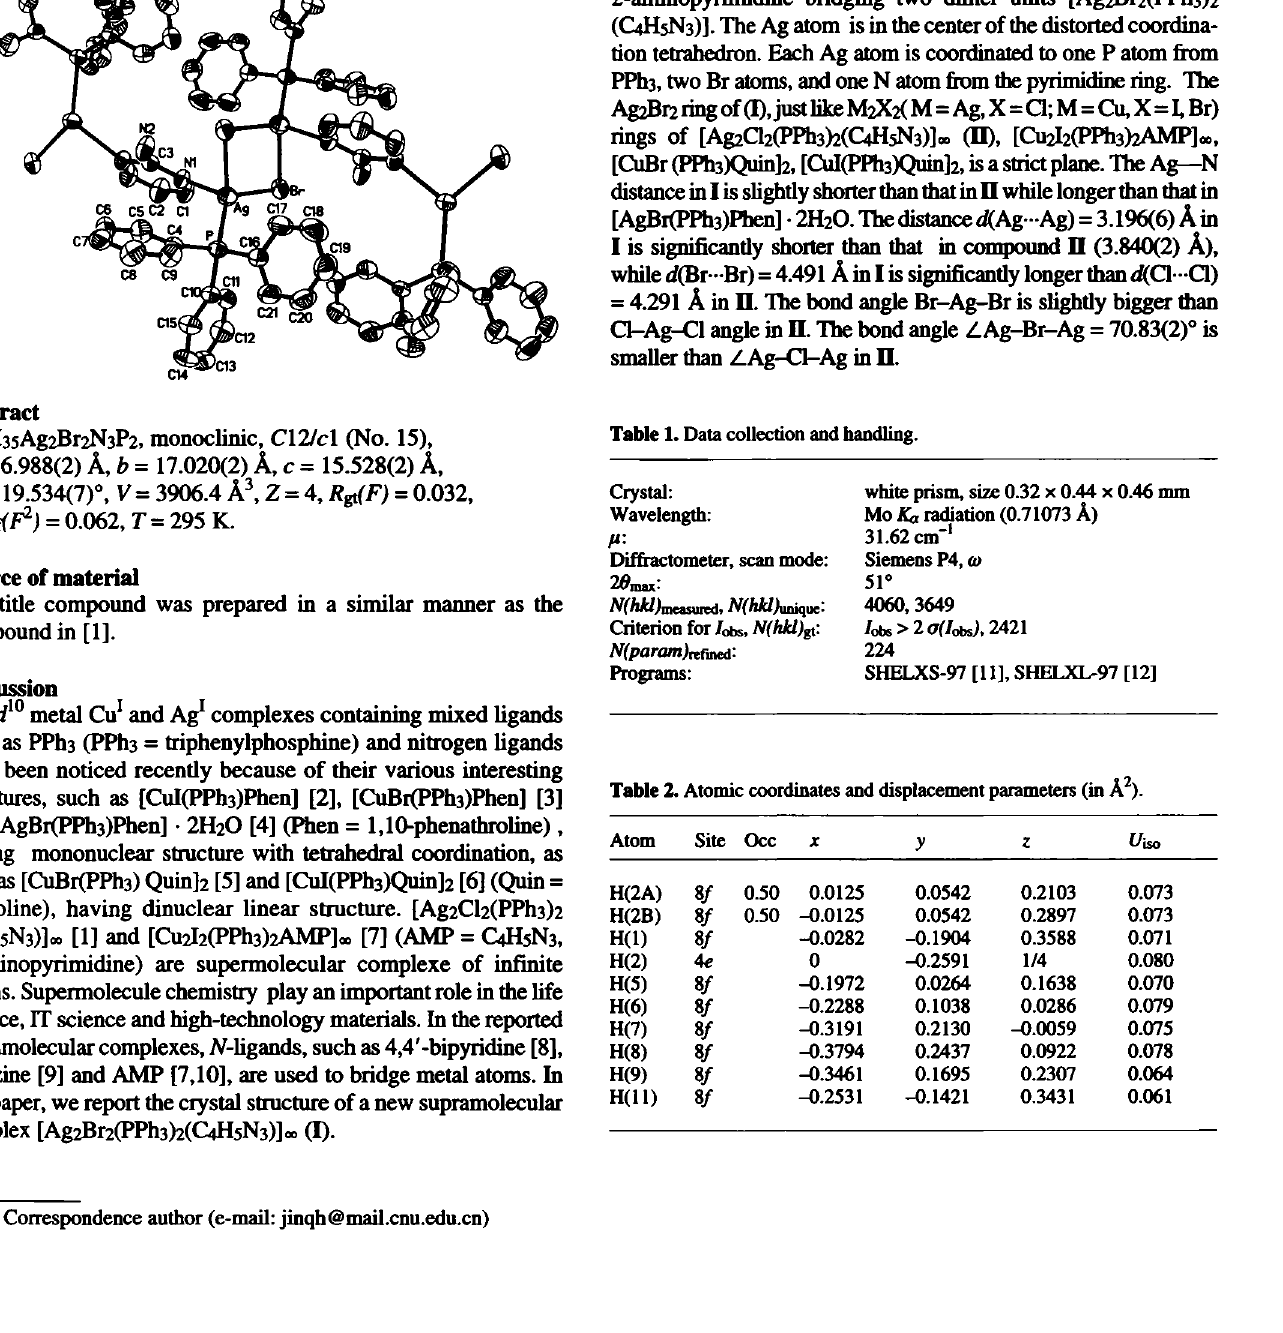
Table 2. Atomic coordinates and displacement parameters (in Â 2